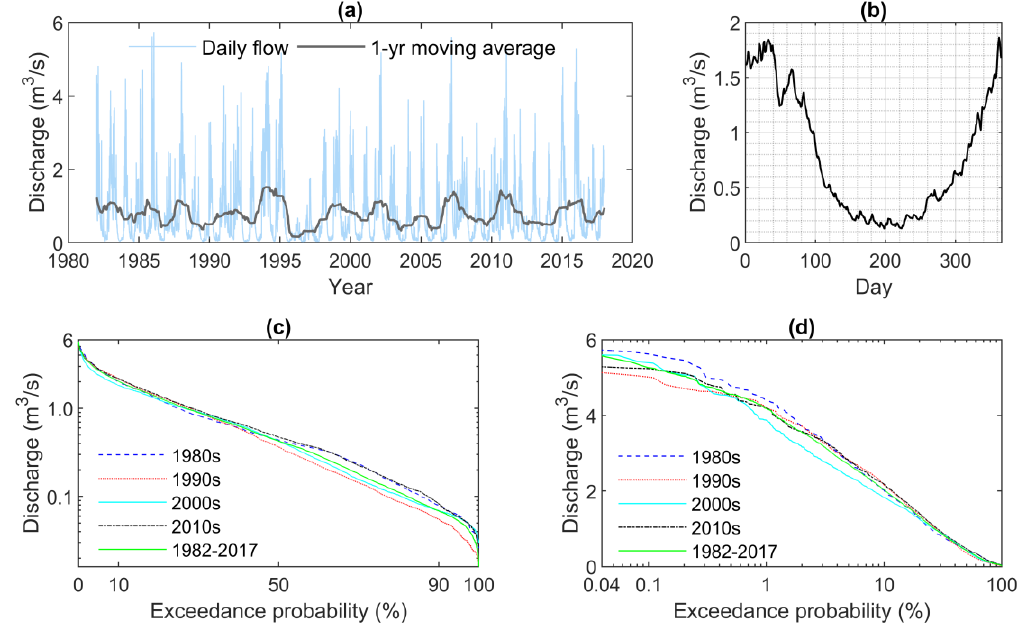
Figure 2. Flow regime of Åmose å. ( a ) Daily discharge during 1982–2017. ( b ) Multi-year averaged daily flow. ( c ) Flow duration curve with the low flow highlighted (discharge in logarithmic scale). ( d ) Flow duration curve with the high flow highlighted (exceedance probability in logarithmic scale).